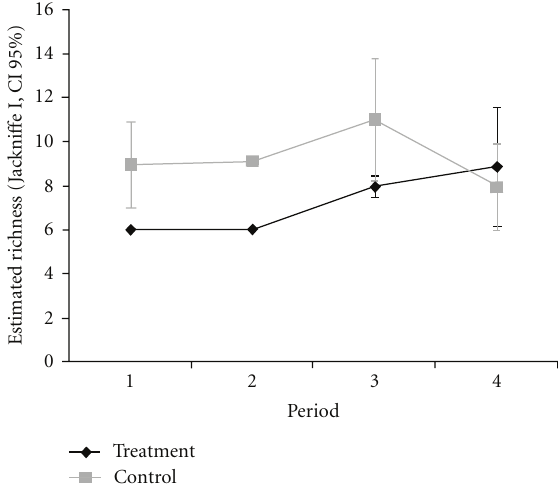
Figure 4: Estimated total richness calculated for the four periods in both groups. Treatment group shows low richness compared to control group in the three first periods.